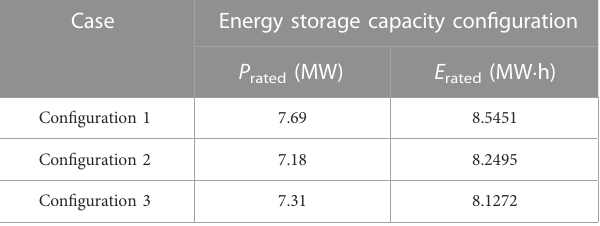
TABLE 4 Energy storage capacity con fi guration considering SFD.